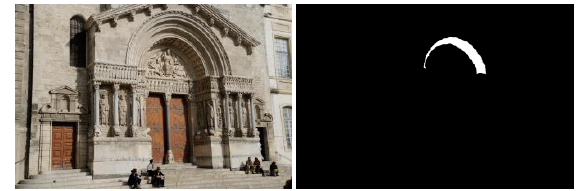
Figure 13: Image (left) and associated mask by the propagation of annotation (right) If the drawn area (corresponding to the annotation) does not Figure 15: Steps of multi-view definition: (a) definition of a ROI on a view and search of X, Y and Z coordinates (pink), (b) definition of a ROI on another view and search of X, Y and Z coordinates (blue), (c) association of the two list of coordinates (green), (d) projection of the modified annotation on others